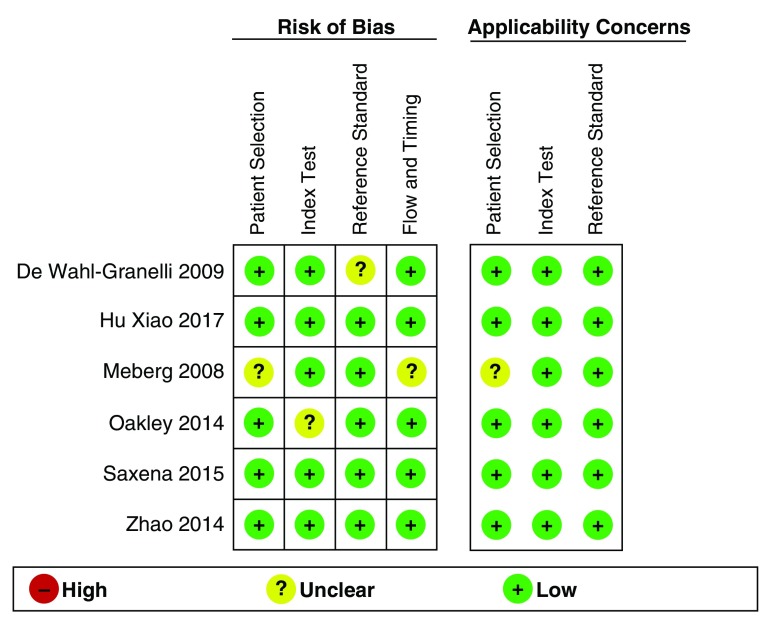
Bias risk and aspects associated with the applicability of every study included.